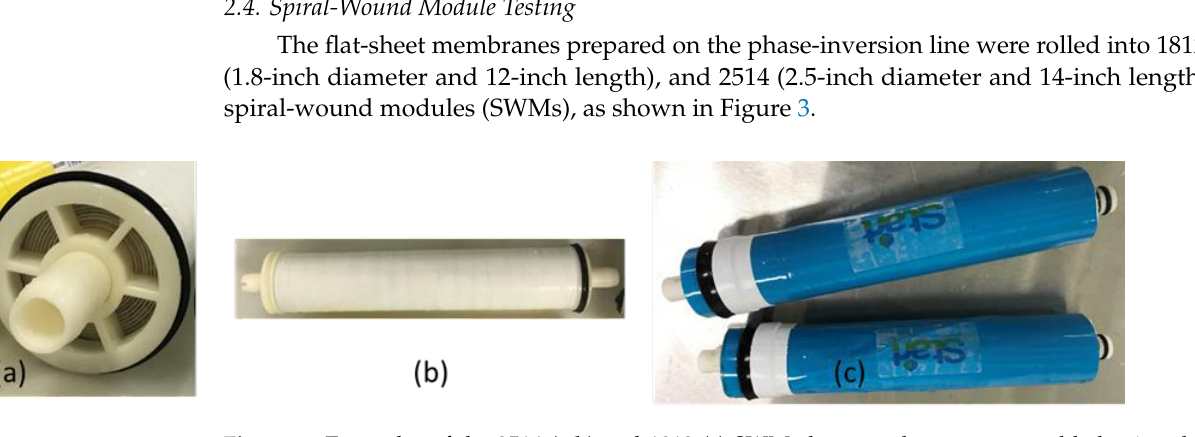
Figure 4. Schematic diagram of the setup used in this study to evaluate the 1812 and 2514 elements.